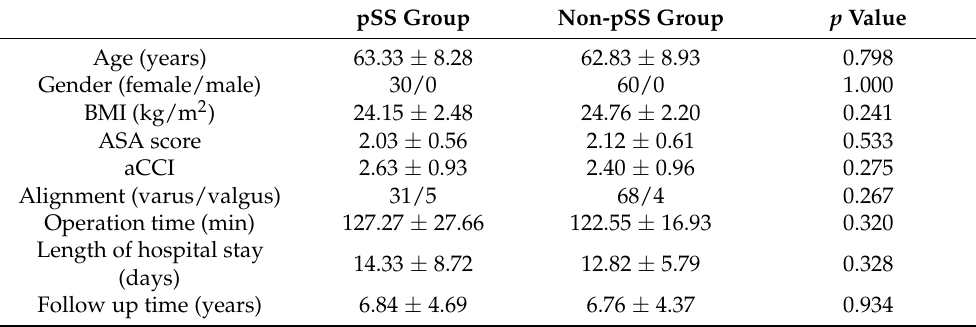
Table 1. Demographic characteristics.